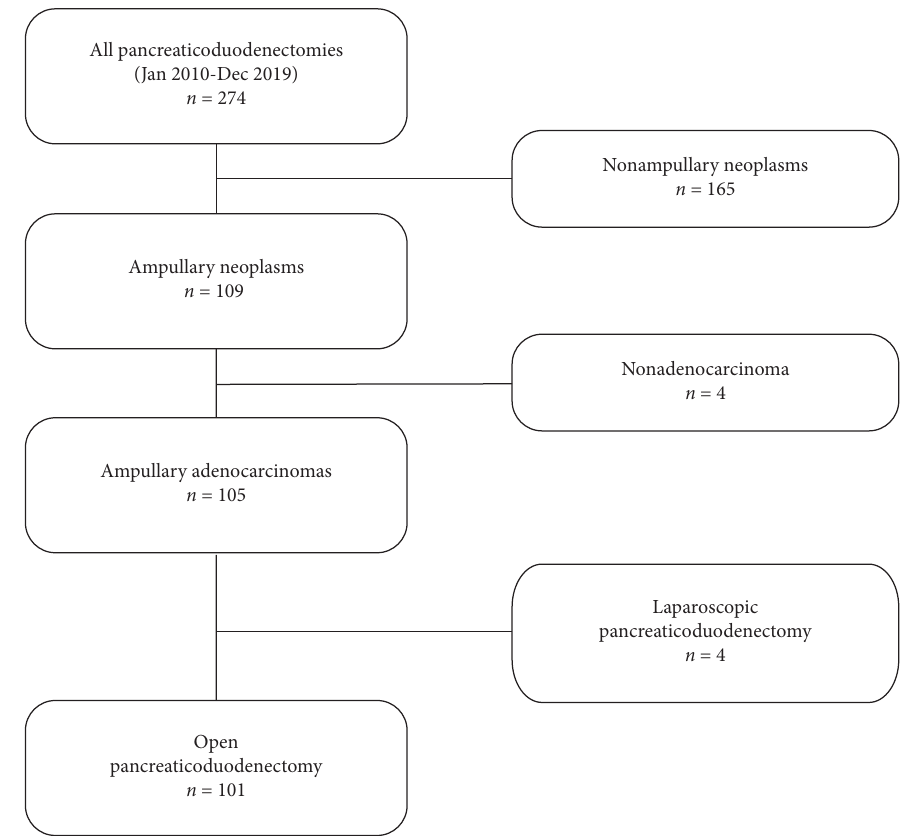
Figure 1: Patient selection flow